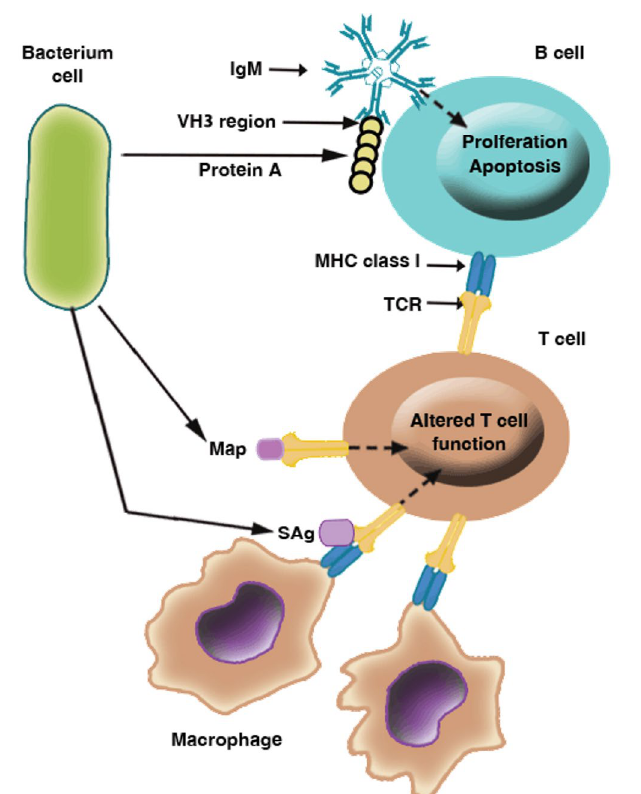
Fig. 6. Mechanisms of immunosuppression mediated by Staphylococcus aureus : This figure illustrates examples of immunomodulatory molecules used by S. aureus to alter the host immune response, including the superantigens (sAgs) enterotoxins and toxic shock syndrome toxin-1 that bind the MHC class II receptor to T-cell receptors; protein A, which binds immunoglobulin M (IgM) VH3 on B cells; and the MHC class II analogue protein Map, which binds the T-cell receptor (TCR) [36, 38, 39, 41]